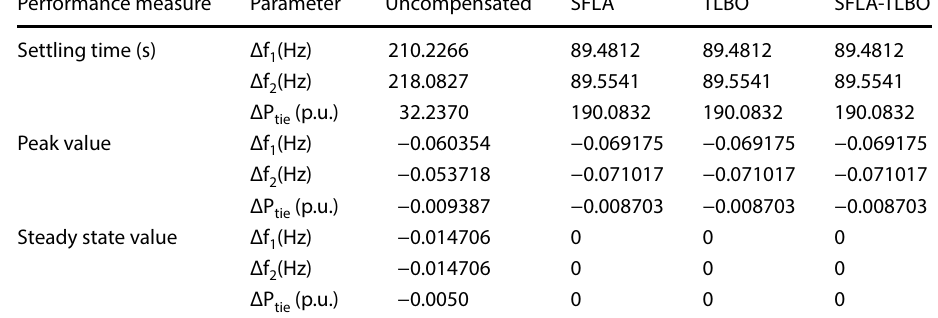
Fig. 14 Tie line power devia- tion for non-linear two-area system